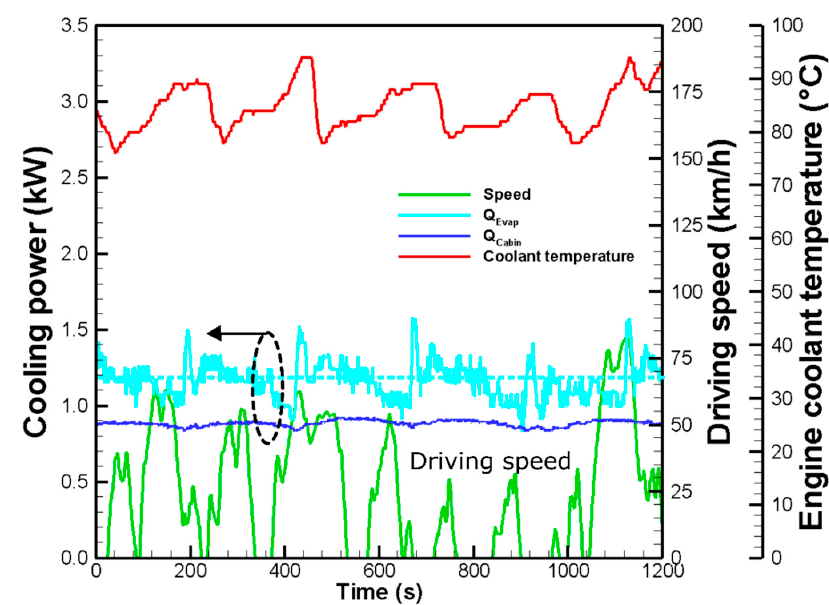
Figure 6. Wind tunnel test (Test no. 2) results of the prototype at constant vehicle speed and 25 °C ambient temperature.